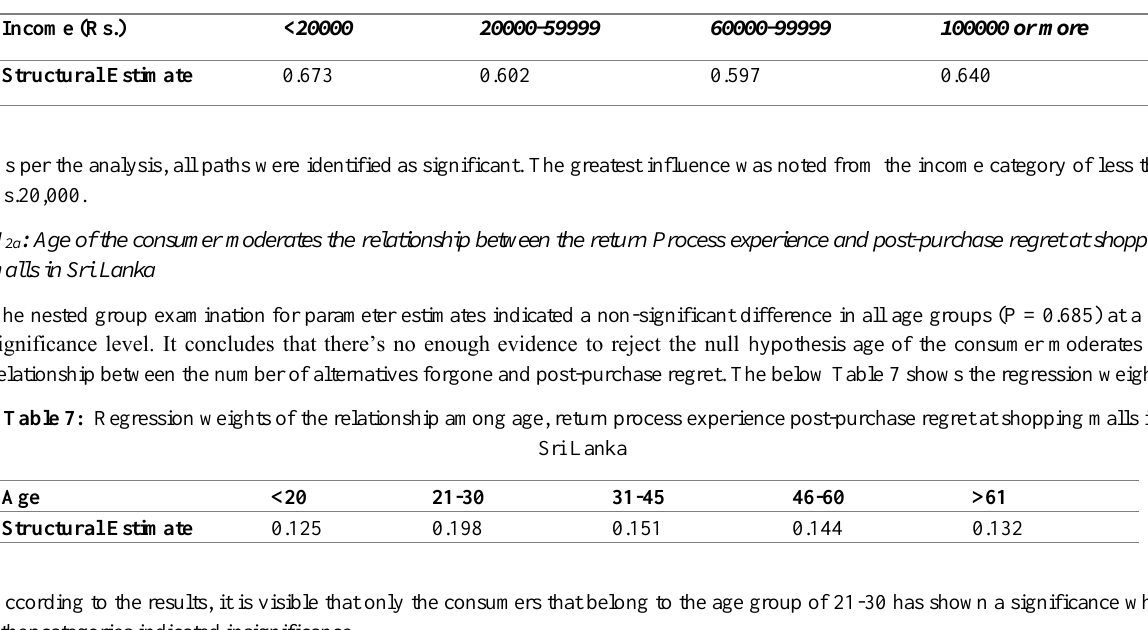
Table 8: Regression weights of the relationship among gender, return process experience post-purchase regret at shopping malls in